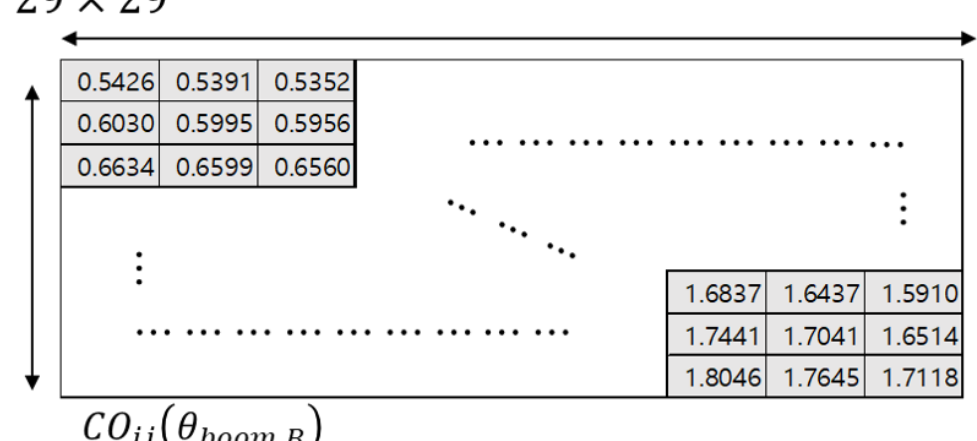
Figure 12. The 29 by 29 matrix about CO ij ( θ boom , B )